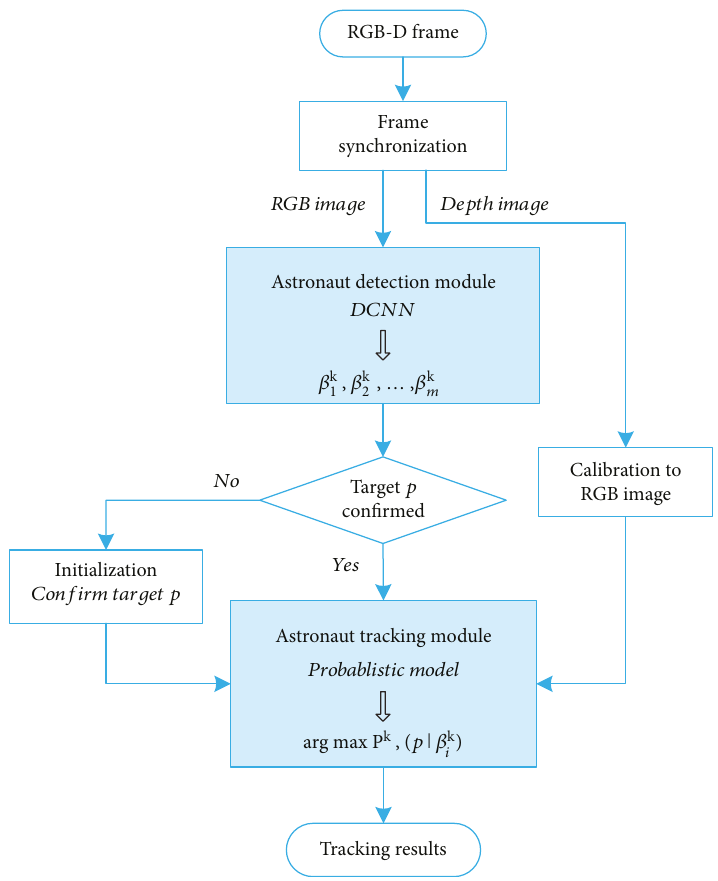
Figure 3: Outline of astronaut tracking